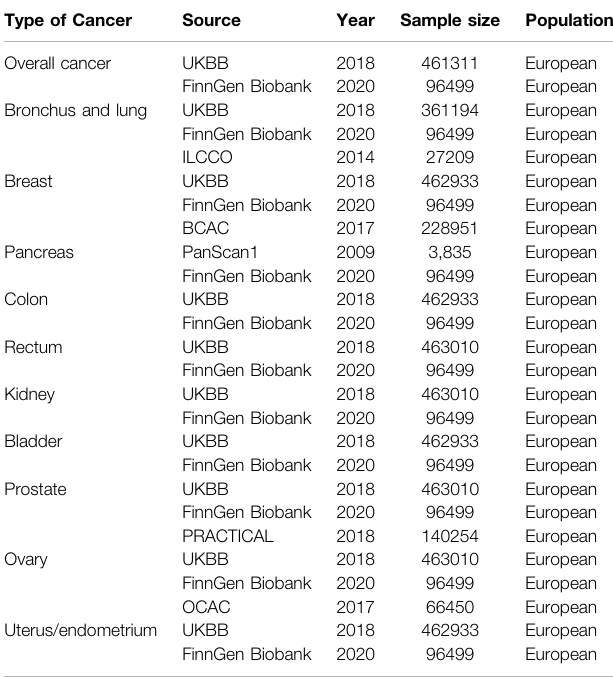
TABLE 2 | Characteristics of included studies or consortia of